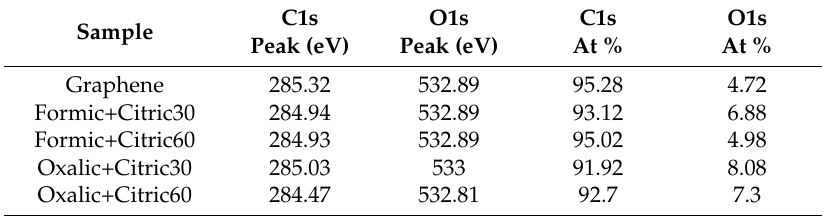
Table 2. Characteristic signals of photoemitted electrons and their respective atomic